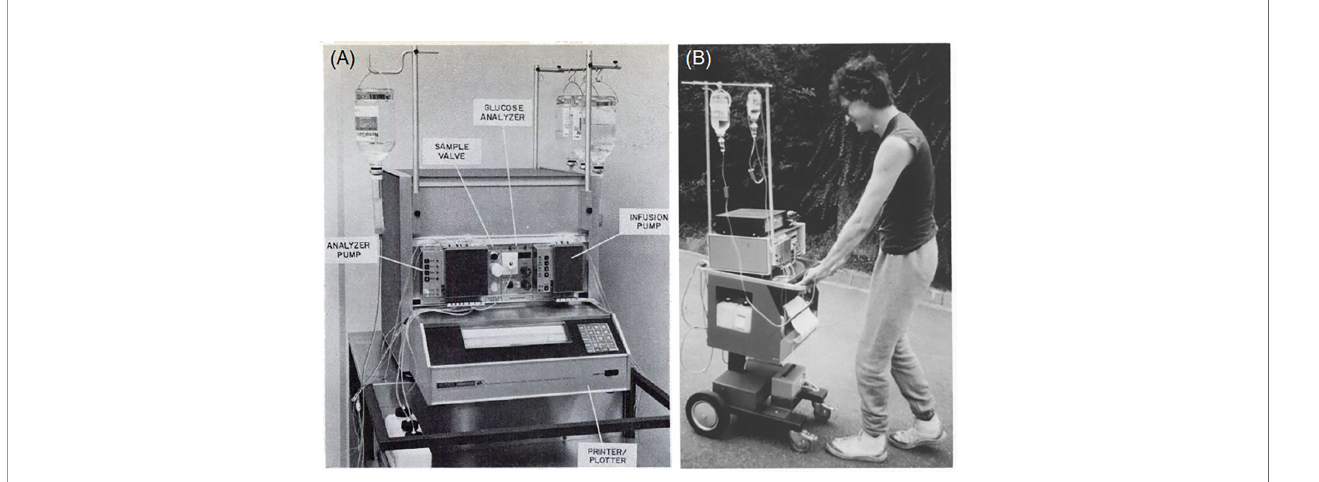
FIGURE 1 | Early closed-loop technologies: (A) Components of the Biostator (reproduced from Fogt et al., 1978); (B) A mobile version of the Biostator (reproduced from Pfeiffer 1987) (10,